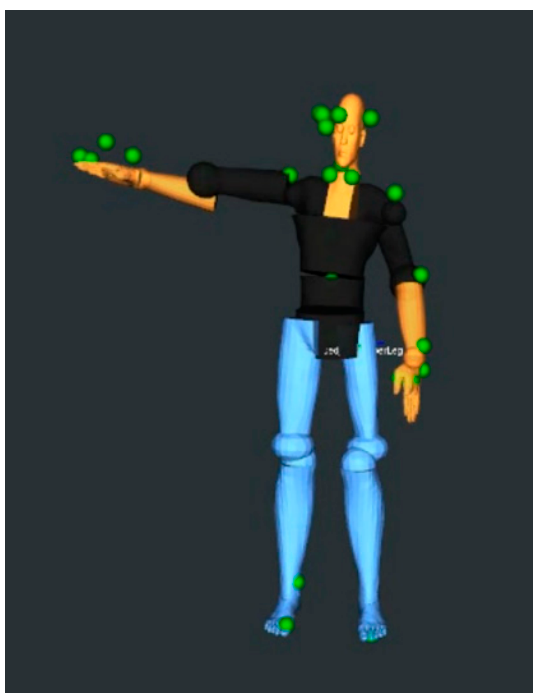
Figure 10. Visualization of the operator (Operator Digital Twin) in RViz. The dots show the MarkerArray published from the vision system.